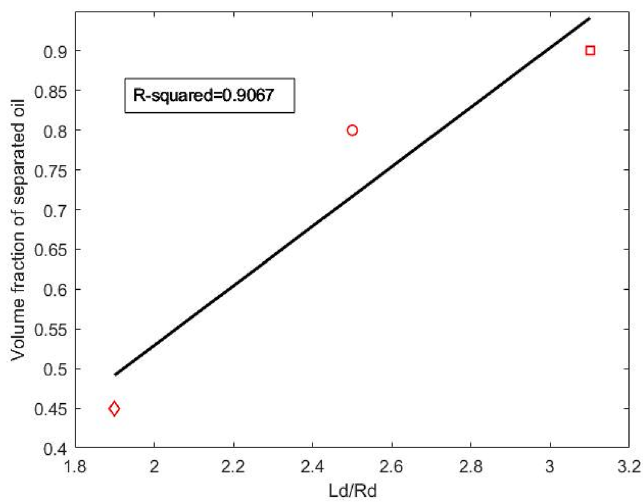
Figure 4. Bottle test results (volume fraction of separated oil) vs. ( L d / R d ) at phase transition points in the synthetic microemulsion system for Mixture (1) (square), Mixture (2) (circle), and Mixture (3) (diamond).